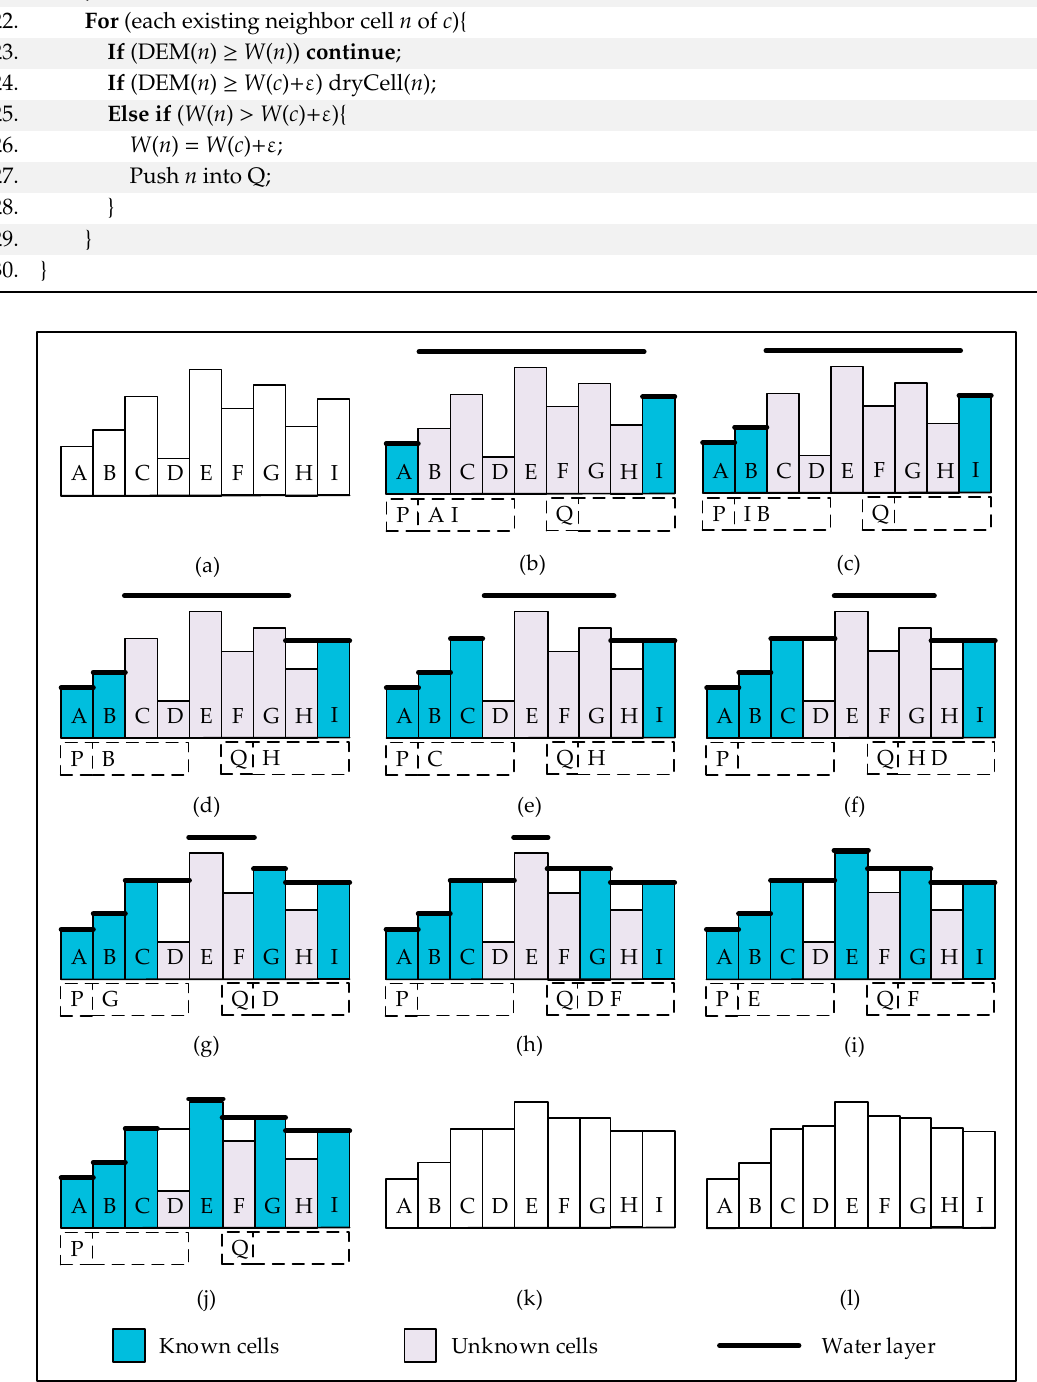
Figure 2. A one-dimensional example of our variant. ( a ) A sample DEM. ( b ) All non-border cells of the DEM are inundated with a thick layer of water. All border cells of the DEM are regarded as known cells and pushed into P. ( c – f ) Cells B and C become known cells and are pushed into P. Cells H and D become unknown cells and are pushed into Q. ( g ) Cell G becomes a known cell and is pushed into P. ( h ) Cell F becomes an unknown cell and is pushed into Q. ( i ) Cell E becomes a known cell and is pushed into P. ( j ) P and Q are empty, our variant ends. ( k ) Depressions in the DEM are filled with strictly horizontal surfaces. ( l ) Depressions in the DEM are filled with slightly sloping surfaces. A two-dimensional example of our variant is also presented in Figure 3. In this example, ɛ is equal to 0.1. A sample DEM with labeled cells is shown in Figure 3a. The sample DEM with elevation values is shown in Figure 3b. In Figure 3c, all non-border cells of the DEM are inundated with a thick layer of water W . All border cells of the DEM become known cells and are pushed into P. In Figure 3d, cells in plain queue P are used as seed cell to drive the RGP. Cells B2, B3, B4, B4, C2, C4, B4, C3, C2 and C3 successively become unknown cells and are pushed into Q. In Figure 3e, cells in Q are used as the seed cell to drive the RGP. Cells C3 and B3 become known cells and are pushed into P because DEM(C3) is greater than W (B4)+ ɛ and DEM(B3) is greater than W (B4)+ ɛ . In Figure 3f, cells C3 and B3 are used as the seed cell to drive the RGP. Cells C2, B2, C2 and B2 successively become